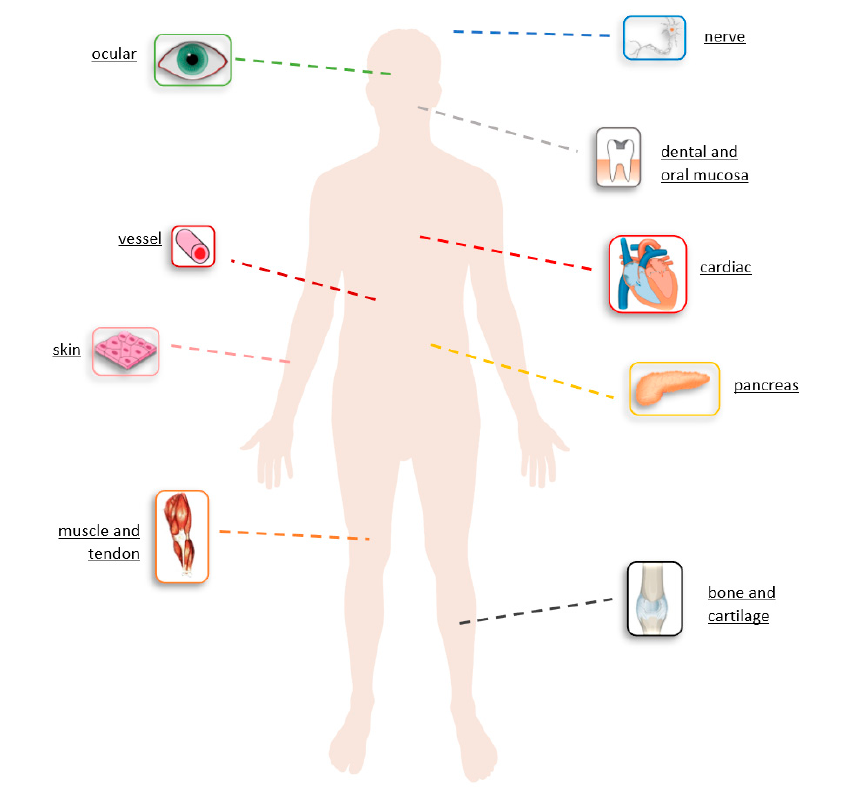
Figure 9. General biomedical application in tissue repair and engineering for different formulation of blended collagen biomaterials. blended collagen